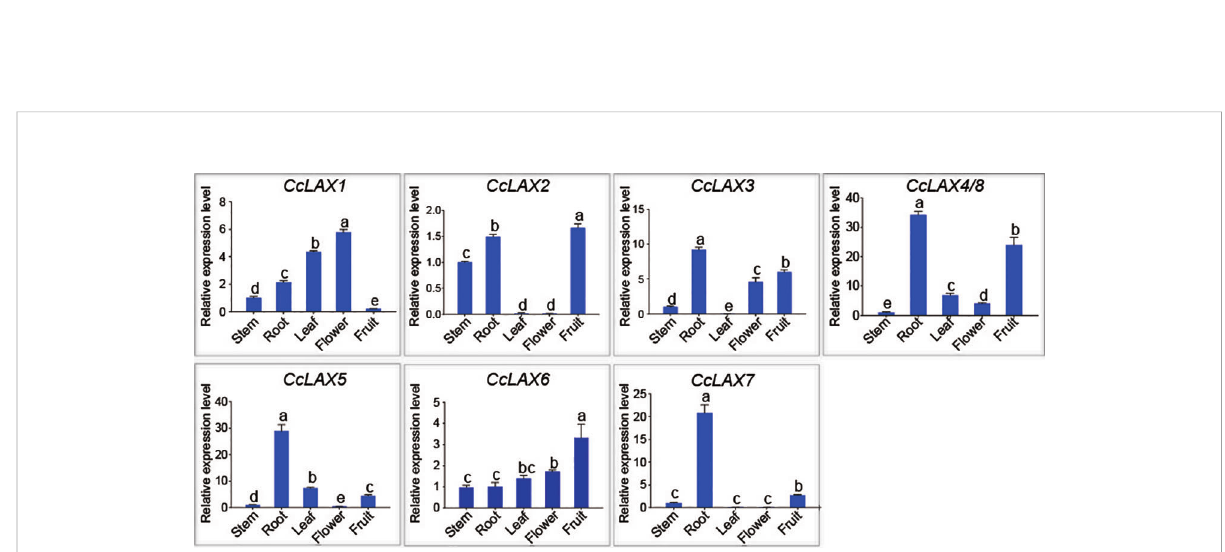
FIGURE 4 Expression patterns of CcAUX/LAX genes in Chinese hickory tissues (stem, root, leaf, fl ower, fruit). The CcActin gene was used as the internal reference gene for normalization. The relative expression levels of each CcAUX/LAX gene in stems were standardized as 1. Different letters represent a signi fi cant level of expression ( P <0.05) in different tissues of Chinese hickory. Multiple comparison test was performed by one-way analysis of variance and Duncan test.